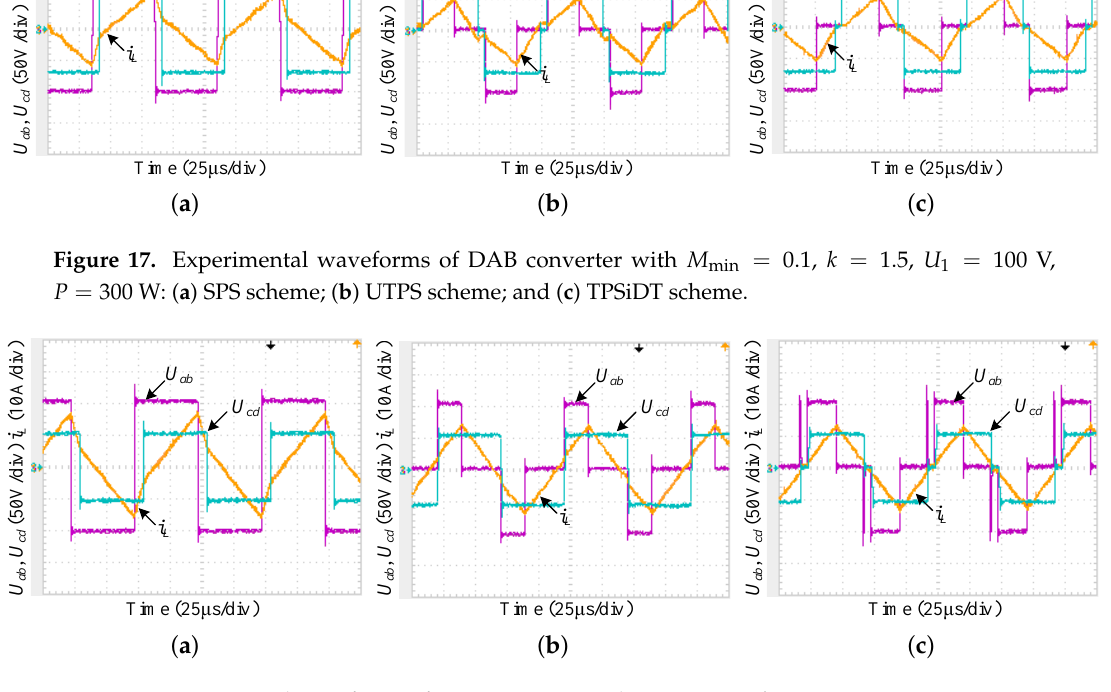
Figure 18. Experimental waveforms of DAB converter with M min = 0.1, k = 2, U 1 = 100 V, P = 300 W: ( a ) SPS scheme; ( b ) UTPS scheme; and ( c ) TPSiDT scheme.